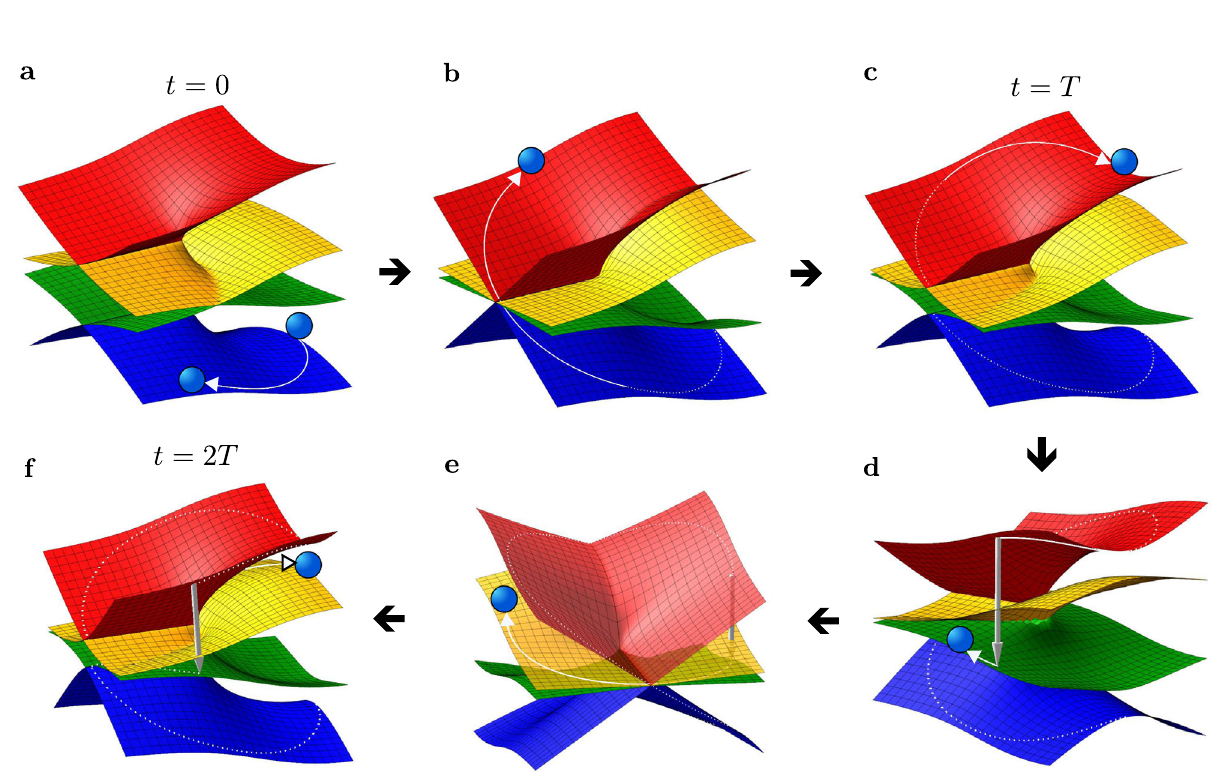
Fig.5|Thetimeevolutionofthesystemstateatdifferenttimes,accordingtoFig.4 a .a Initialstate t =0, b T /2< t < T , c t = T , d T < t <3 T /2, e 3 T /2< t <2 T , f fi nalstate t =2 T . See also the main text for